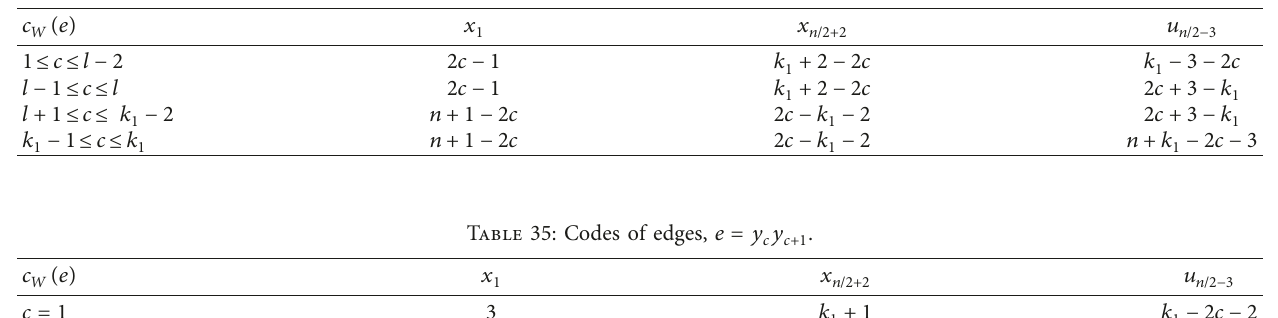
Table 34: Codes of spokes, e � x